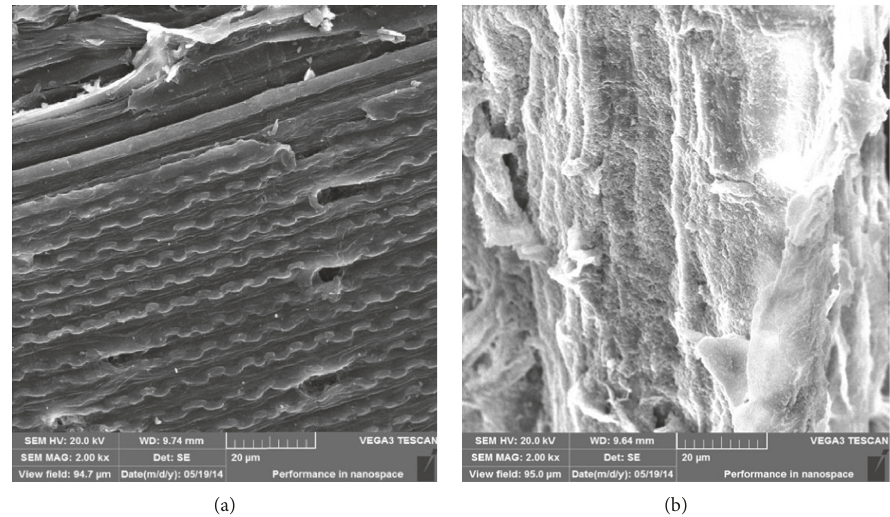
Figure 9: SEM images of modified rice stem: (a) before adsorption of uranium(VI) (2000x); (b) after adsorption of uranium(VI) (2000x).